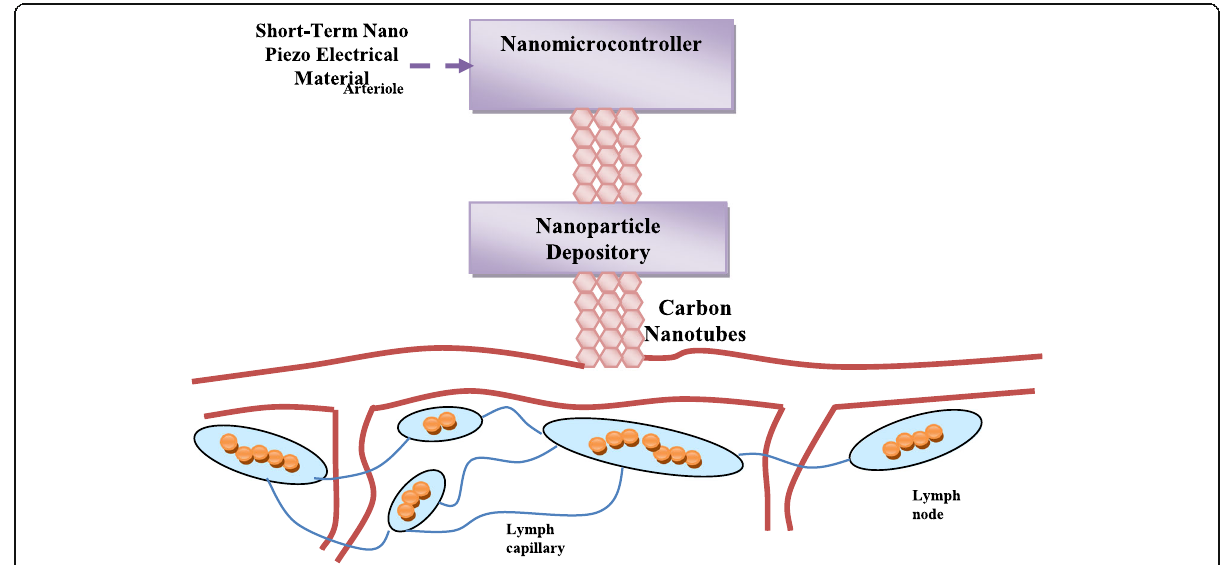
Fig. 2 General structure showing the association of the proposed drug system with the infected cells